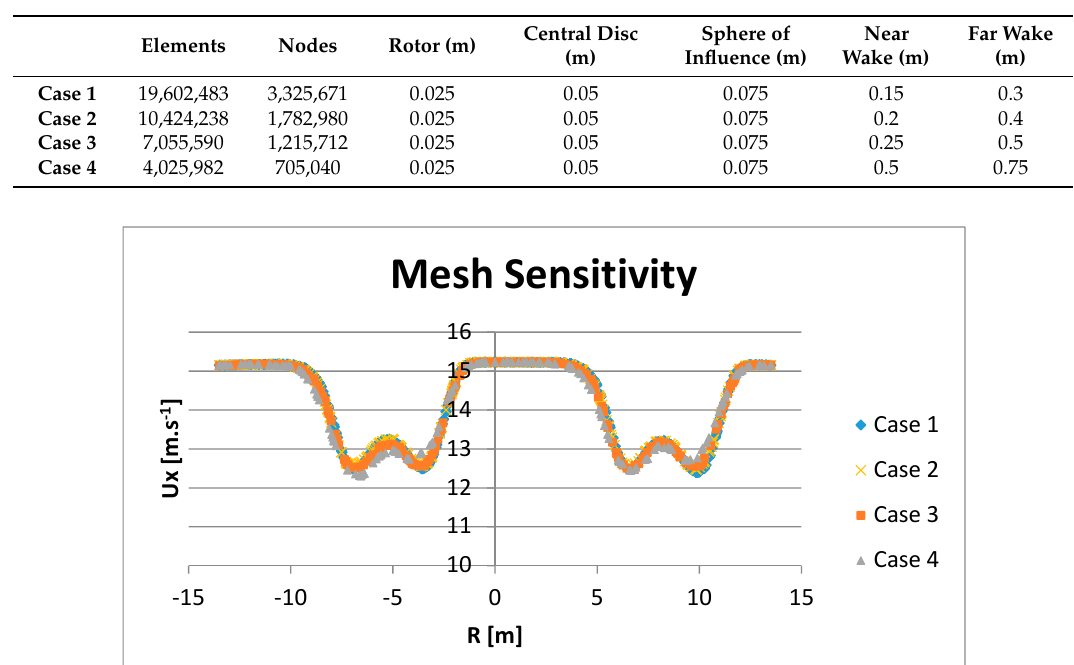
Figure A1. Physical domain showing the refinement of the mesh at different regions in the wake. Table A1. Four cases of mesh sensitivity study.